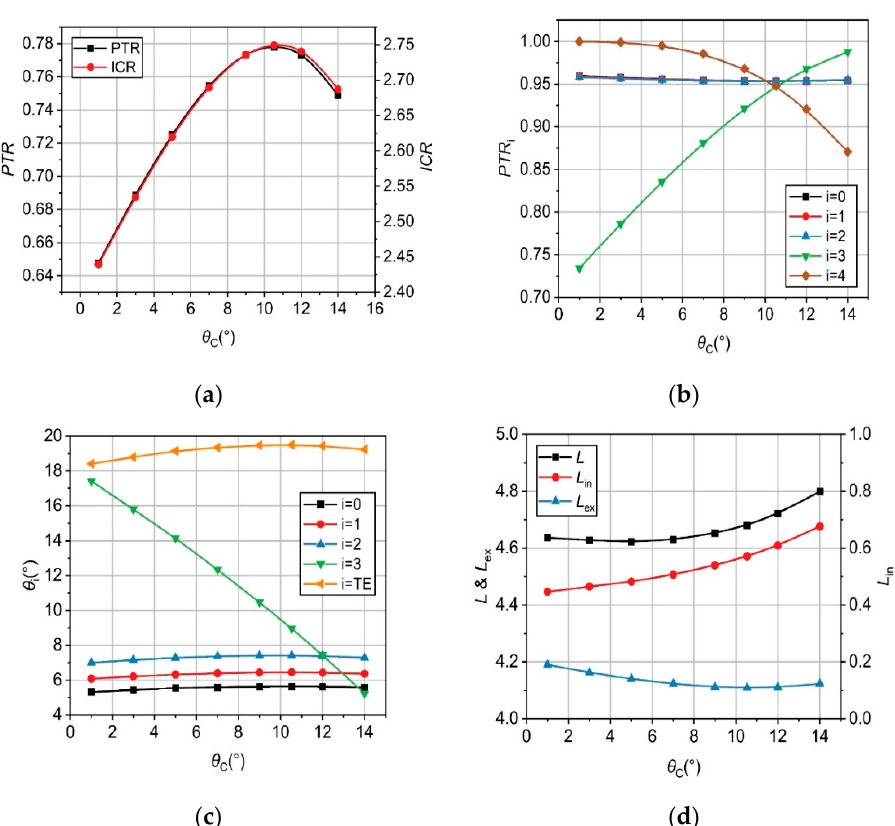
Figure 4. Influences of the cowl internal angle on ( a ) the total pressure recovery and IC; ( b ) the pressure recovery of a single shock; ( c ) the flow turning angle; and ( d ) the inlet length and length distribution.